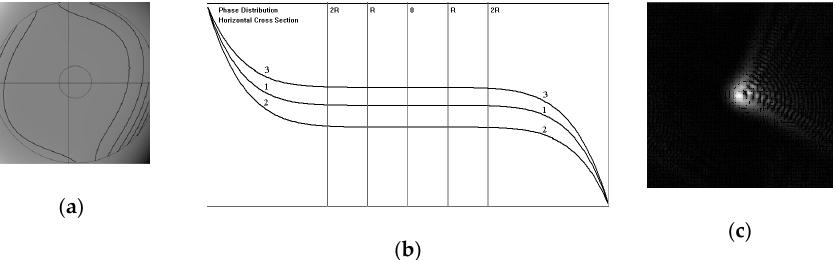
Figure 7. The same as in Figure 2, the phase was specified by the sum of polynomials from 1 to 7. Phase surface ( a ), cross-sections of phase surface ( b ) and corresponding amplitude distribution ( c ) are shown.